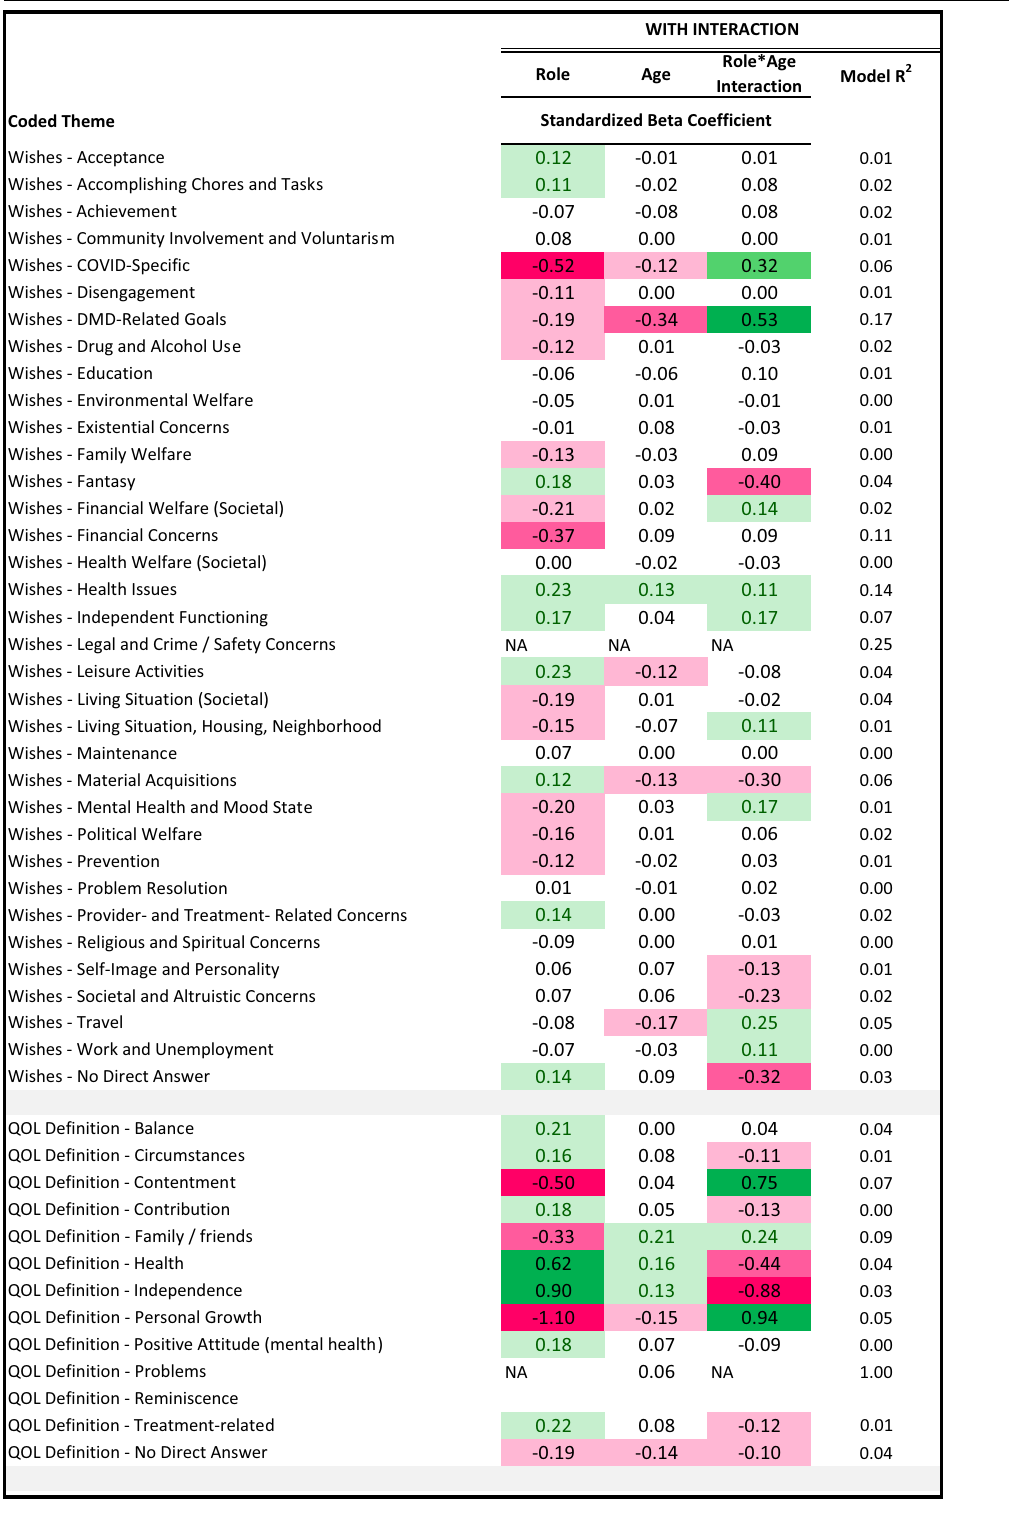
Table 4 Results of patient vs. comparison groups’ multivariate logistic models predicting coded